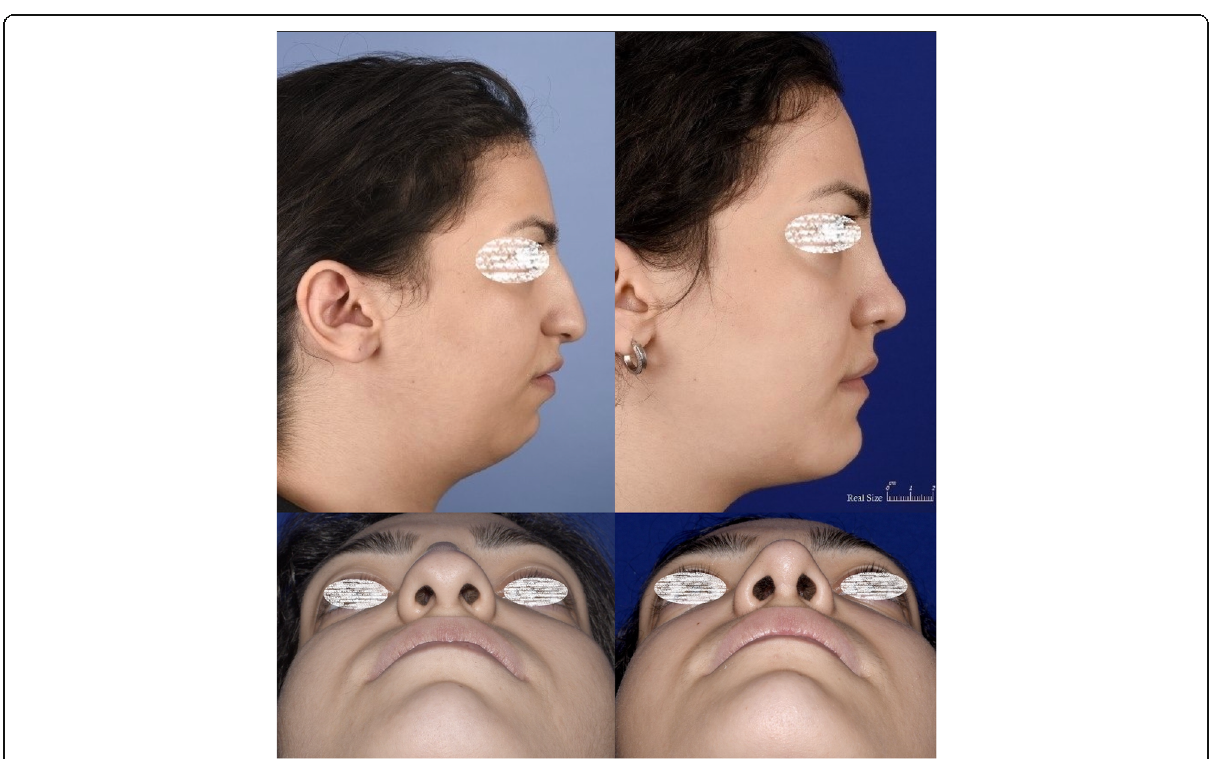
Fig. 6 Patient who underwent rhinoplasty with sill graft. The figure shows preoperative and postoperative views from frontal aspect ( a , b ) and basal aspect ( c , d ). b , d Postoperative